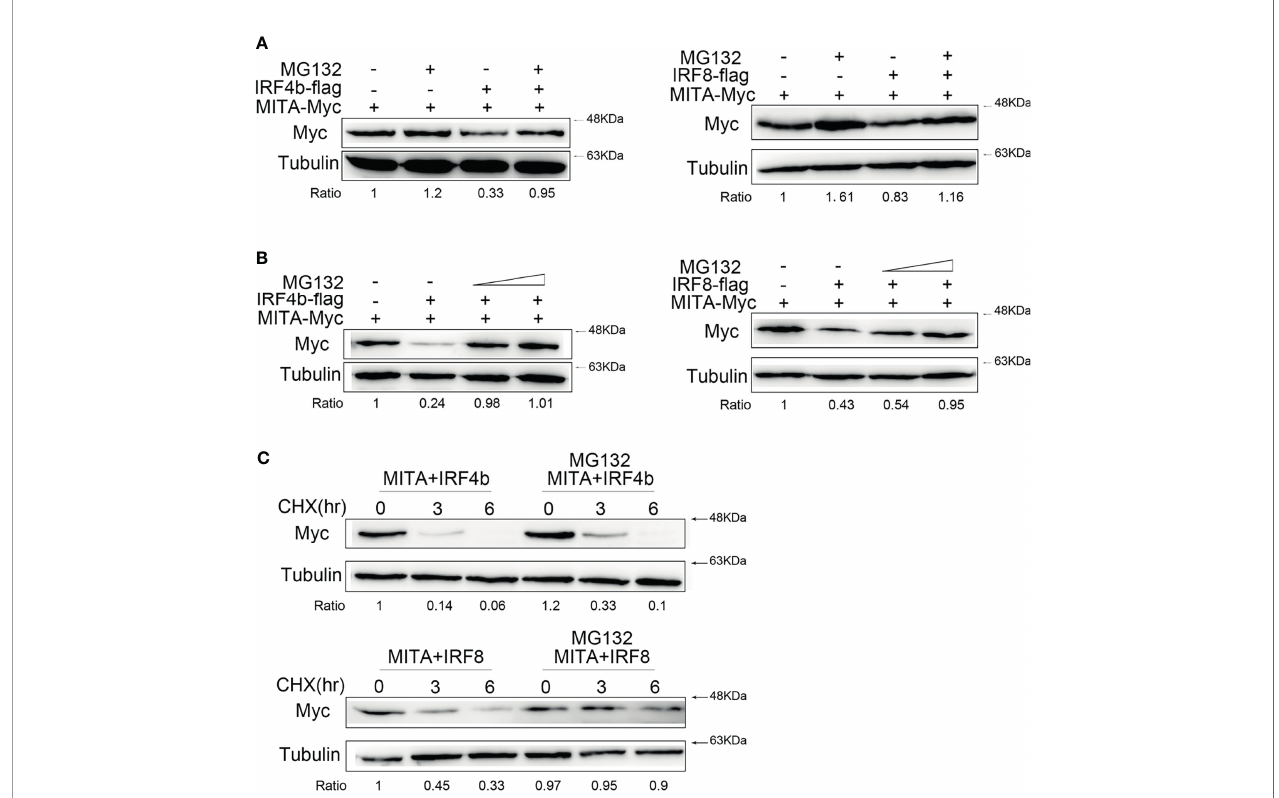
FIGURE 6 | IRF4b and IRF8 promote MITA degradation through proteasome pathway. (A) EPC cells were seeded on 12-well plates and transfected with 0.4 m g of MITA and IRF4b or IRF8 for 24 h, and then the cells were treated with DMSO or 30 µM MG132 for 10 h. The expression of MITA was determined by immunoblot assays. (B) EPC cells were transfected with 0.4 m g of MITA, IRF4b, or IRF8 again, and increasing doses of MG132 (15 and 30 µM) were added to the cells for 12 h. The expression of MITA was checked by immunoblot assays and normalized to tubulin. (C) EPC cells were transfected with 0.4 m g of MITA and IRF4b or IRF8 as designed in (C) . At 24 h after transfection, MG132 (30 µM) and CHX (100 µg/ml) were added into cells, and cells were lysed at different time points. The protein level of MITA was examined by immunoblot assays. All the experiments were performed independently at least three